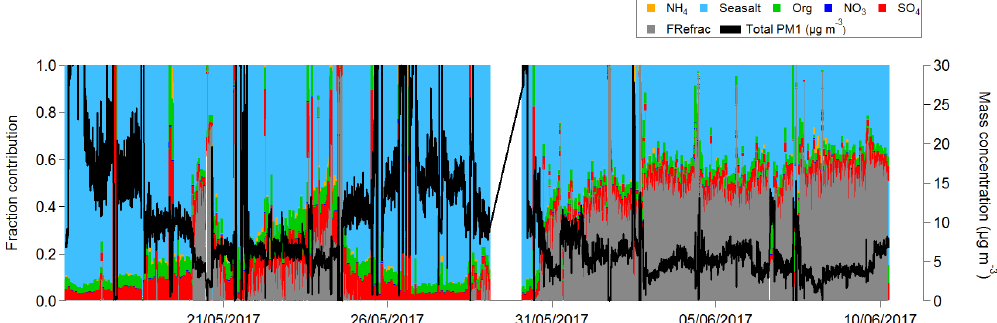
Figure 2. Time series of the fractional contribution of different species to the ToF-ACSM signal, as well as the total mass concentrations measured by the ACSM (black), and the missing fraction relative to the DMPS measurement (FRefrac) in grey.